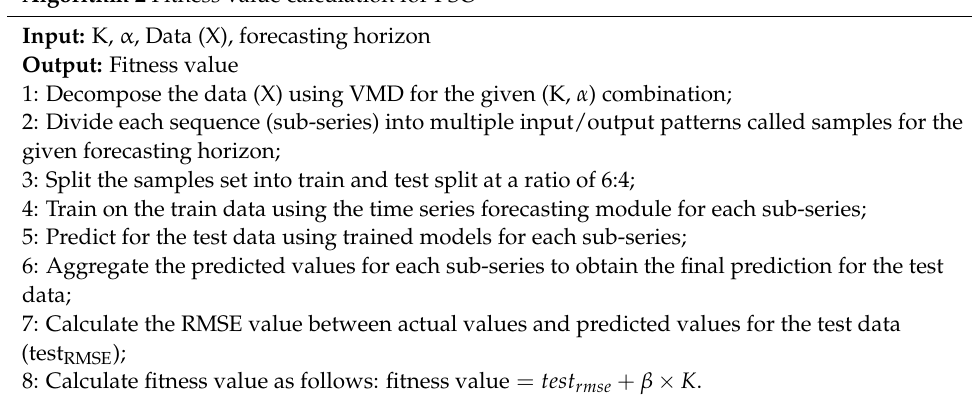
Algorithm 2 Fitness value calculation for PSO